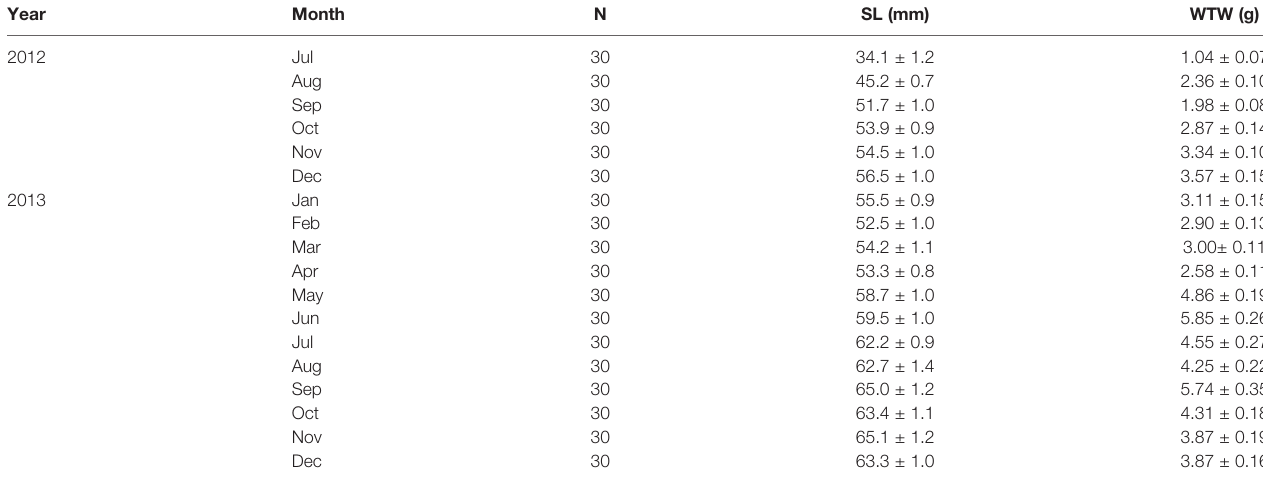
TABLE 1 | Shell length (SL) and wet tissue weight (WTW) of the off-bottom rack cultured oysters at the Euhangri beach from July 2012 to December